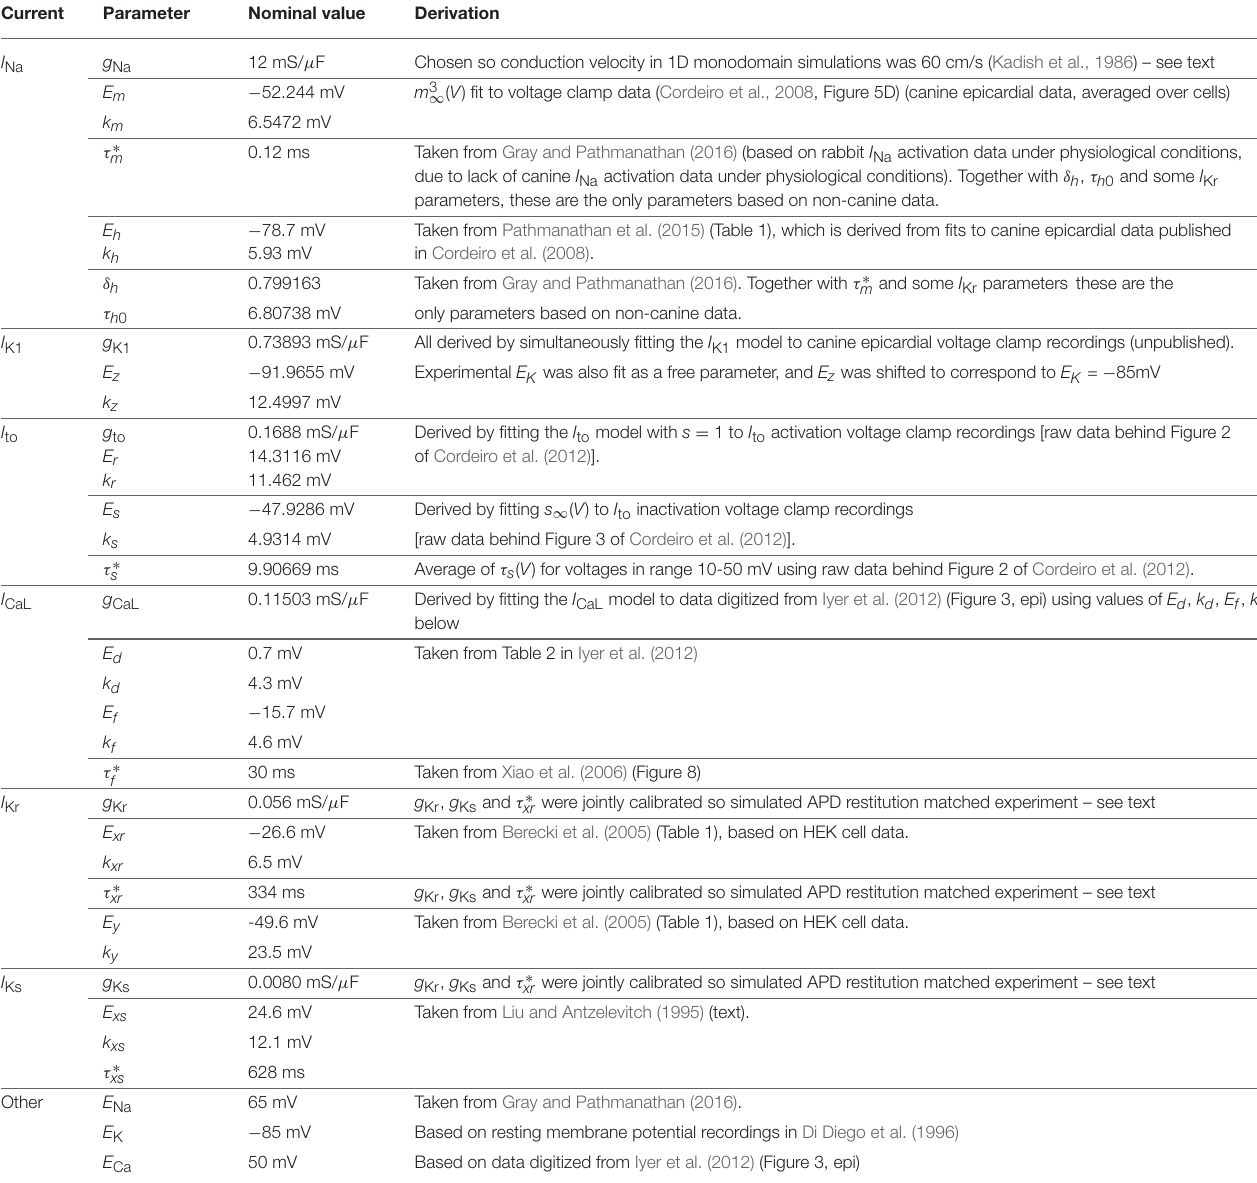
TABLE 1 | Parameters in cell model, with nominal values and derivation of value.